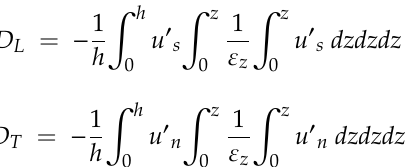
Figure 2. Conceptual diagrams of the computation procedures in the particle tracking model (PTM). In the 2D analysis, the deterministic displacement in Equation (8) is governed by the depth-averaged velocity fields calculated from the flow analysis model, Hydro Dynamic Model-2D (HDM-2D), which has been validated for several open channel flows [34]. The random transport term is controlled by the dispersion coe ffi cient and the random number following the Gaussian distribution